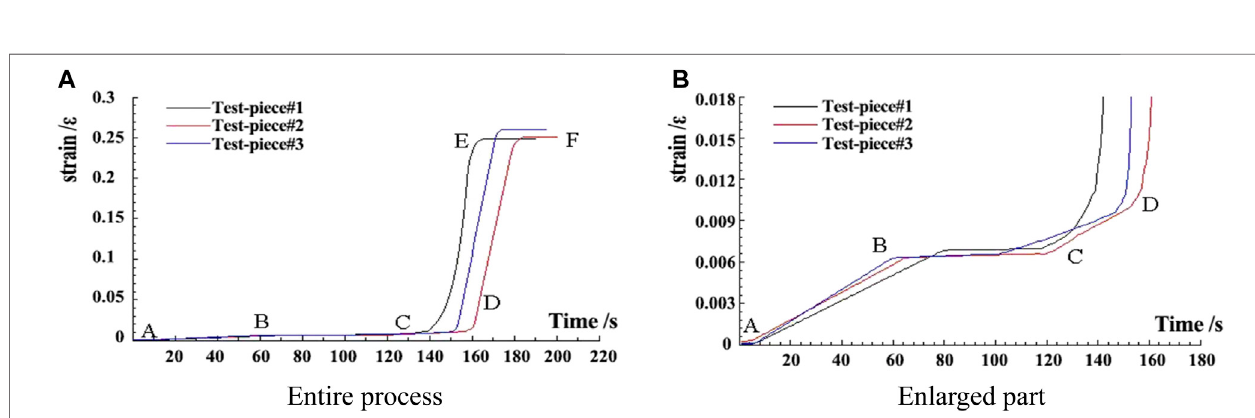
Frontiers in Earth Science |